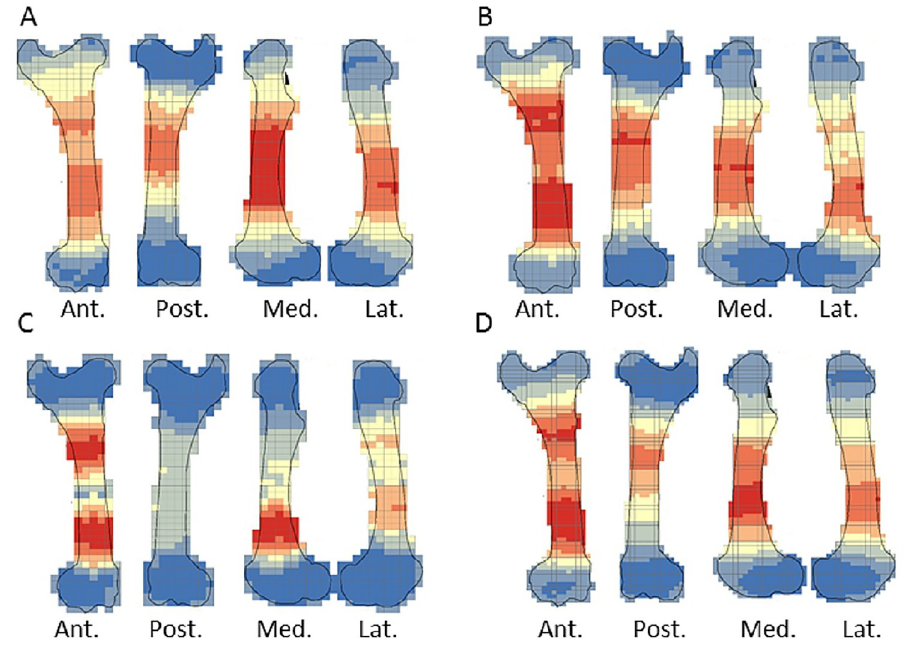
Fig 9. Optimized hot spot analysis of combined percussion marks from the femurs in each series. A- Individual n˚ 3; B- Individual n˚5; C- Individual n˚8; D- Merged femurs series (Ind.: Individual).